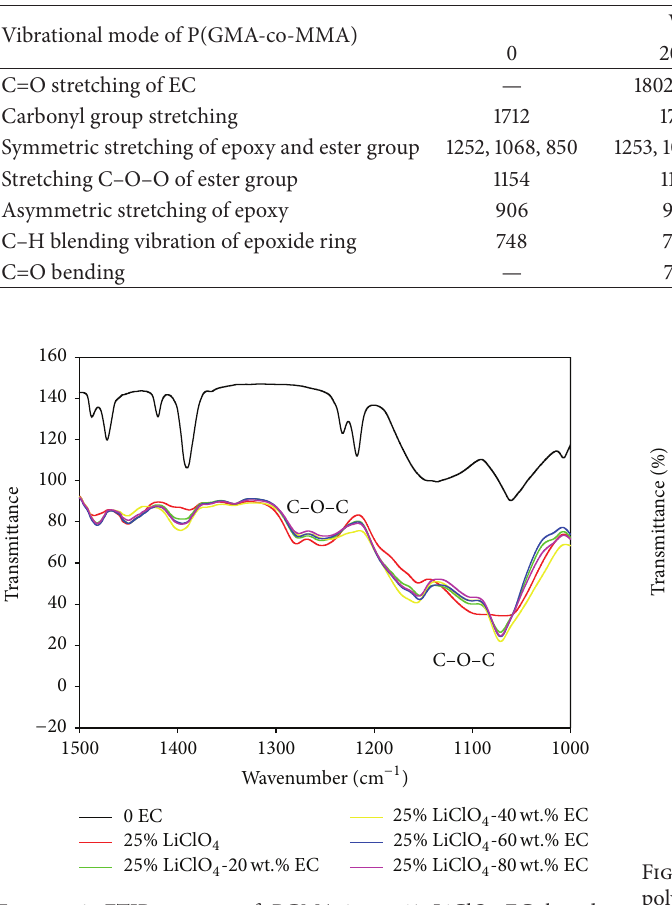
based polymer electrolyte with different percentage of EC. 4